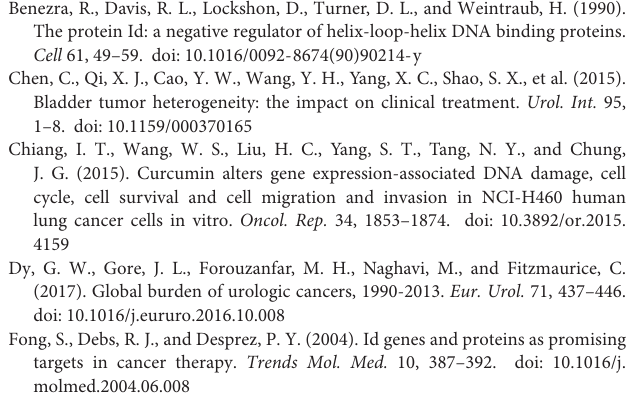
Supplementary Figure 1 | Expression of ID1, ID3, and ID4 in the TCGA database. (A) ID1 expression profile across all tumor samples and paired normal